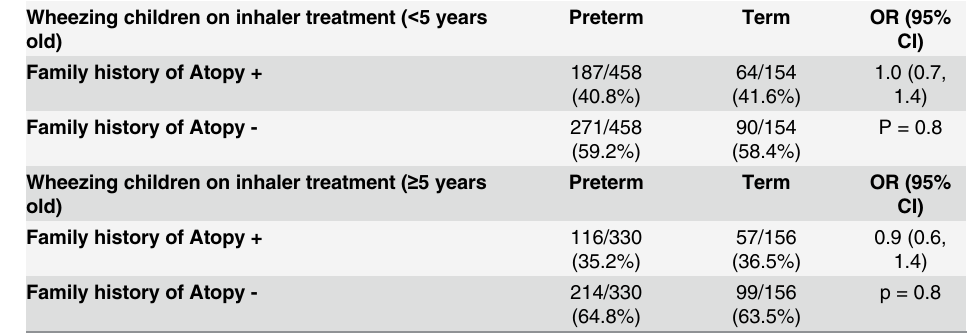
Table 5. The influence of family history of atopy on wheezing children being treated with inhalers by comparing preterm to term-born participants for both age